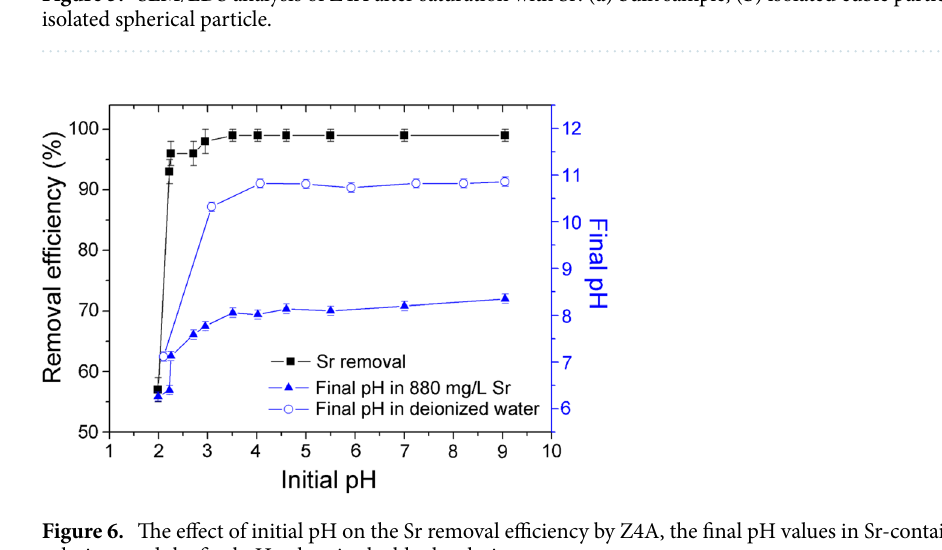
Figure 6. The effect of initial pH on the Sr removal efficiency by Z4A, the final pH values in Sr-containing solutions and the final pH values in the blank